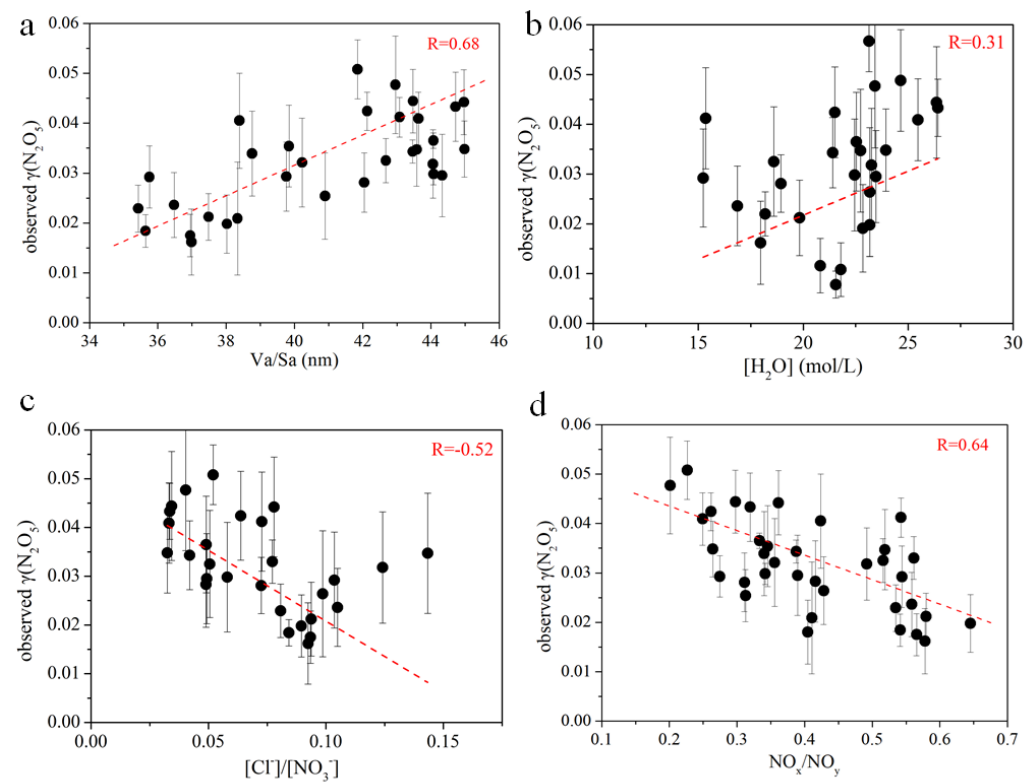
Figure 6. Dependence of γ(N 2 O 5 ) on several parameters in urban air masses: ( a ) V a /S a ; ( b ) aerosol water content ([H 2 O]); ( c ) molar ratio of aerosol chloride to nitrate in the aqueous phase ([Cl − ] / [NO 3 − ]); ( d ) ratio of NO x to NO y (NO x / NO y ). The error bars of γ(N 2 O 5 ) have the same meaning as in Figure 5.